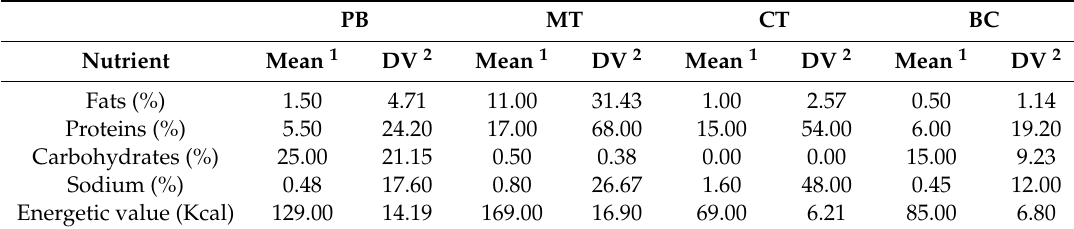
Table 4. Nutritional profile of the